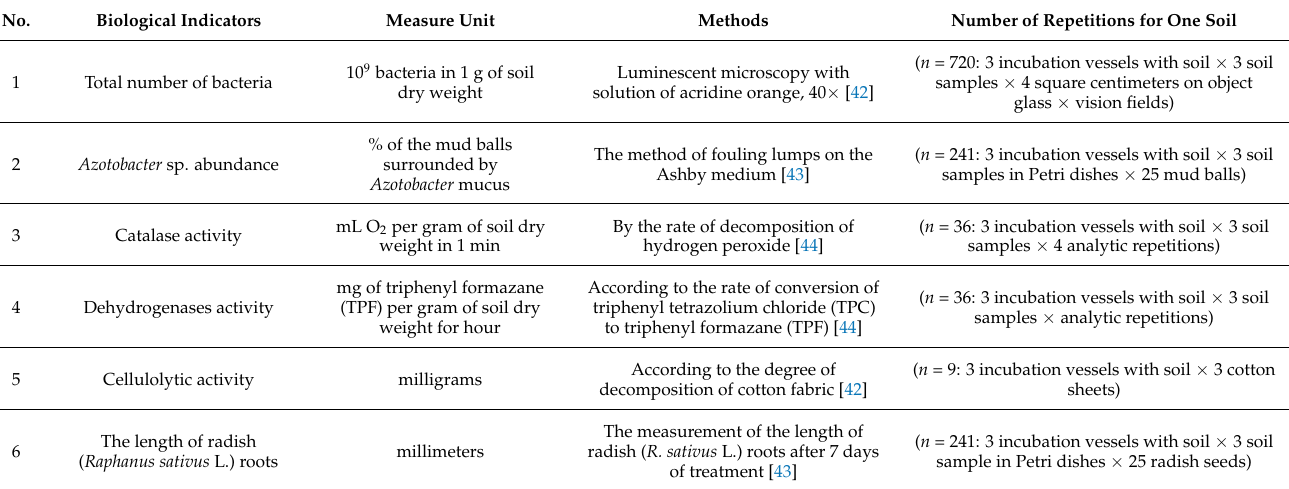
Table 2. Characteristics of biological indicators of soil